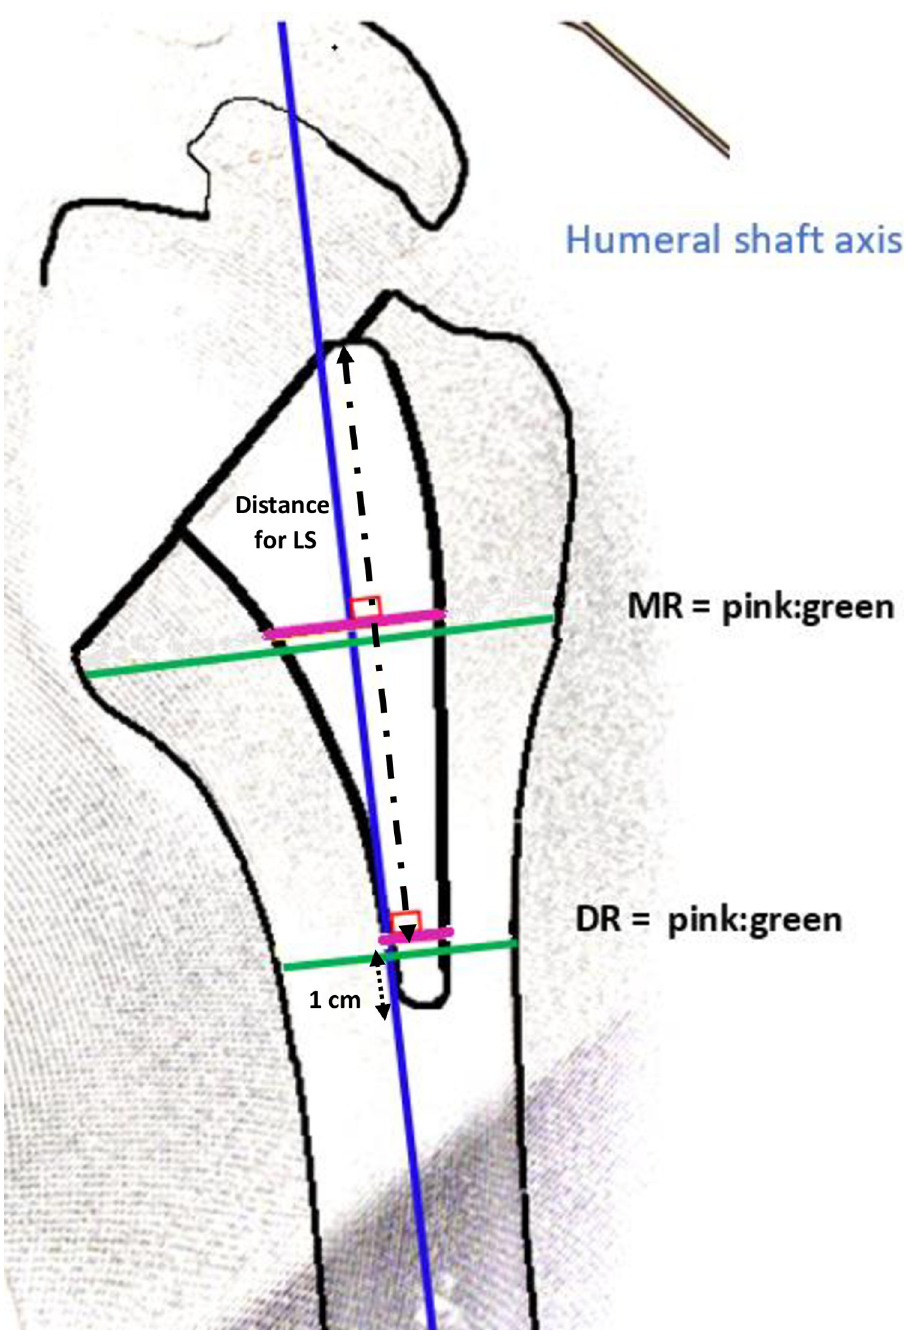
Fig 3. Humeral draw of anteroposterior radiograph. Metaphyseal filling ratio (MR) and diaphyseal filling ratio (DR) obtained by calculating the ratio between the stem diameter (pink line, ) and the diaphysis diameter (green line, ). The measured distances are perpendicular to the axis of the humeral shaft. The MR is measured at the level of the cut, and the DR is measured 1 cm over the tip of the short-stem (dotted arrow, ), and at that same level for long stem (dashes arrow,